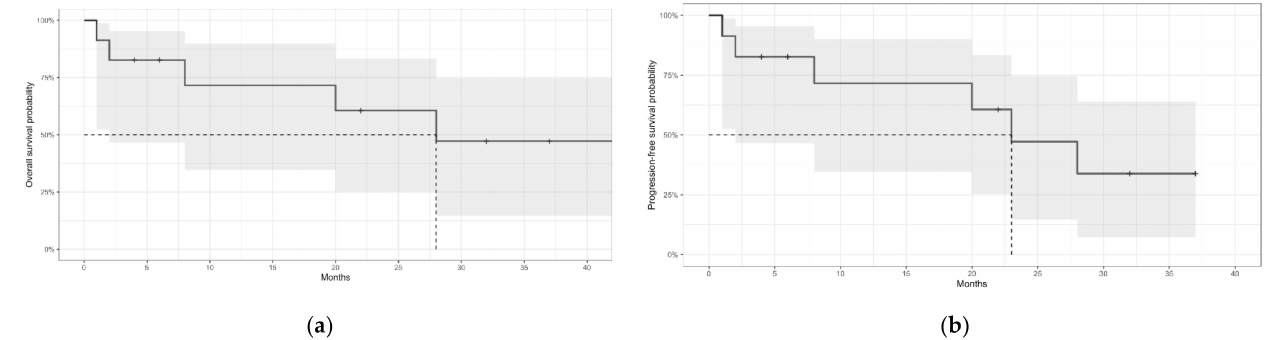
Figure 1. ( a ) Overall survival of patients with Bing-Neel syndrome. ( b ) Progression-free survival of patients with Bing-Neel syndrome. Grey areas represent the 95% confidence intervals. The dotted lines indicate the median